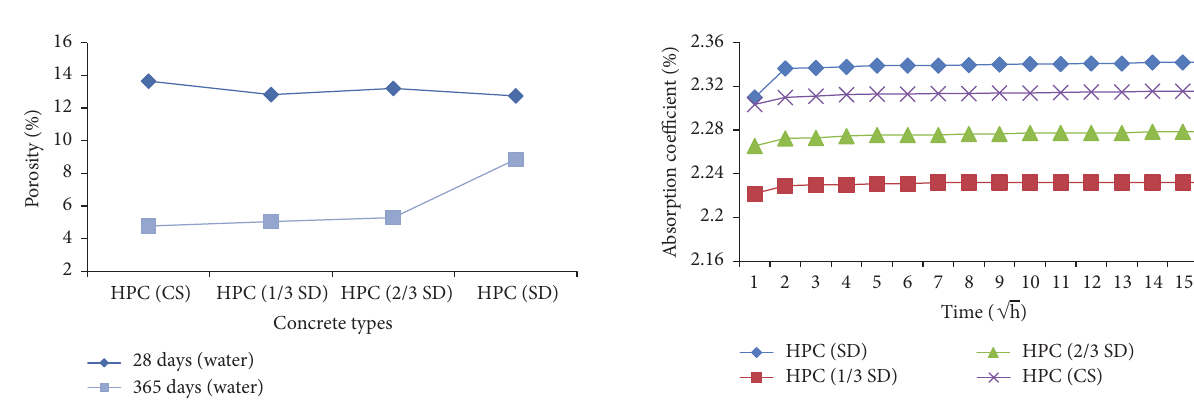
Figure 6: Variation of the porosity of various percentages of CS conservation in potable tap water.